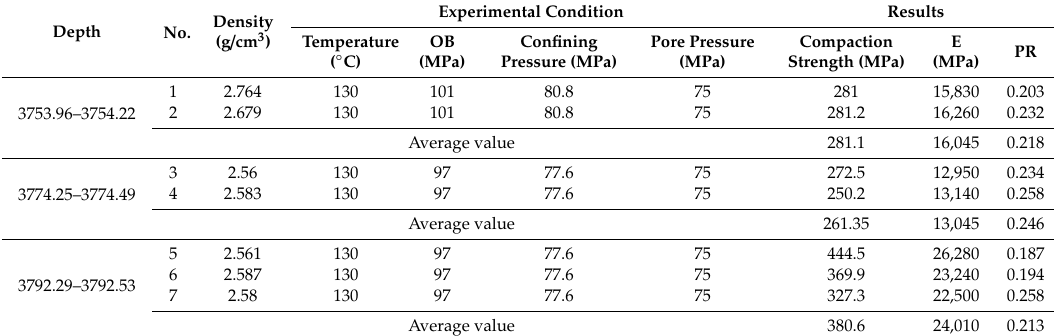
Table 1. Rock mechanical parameters testing of